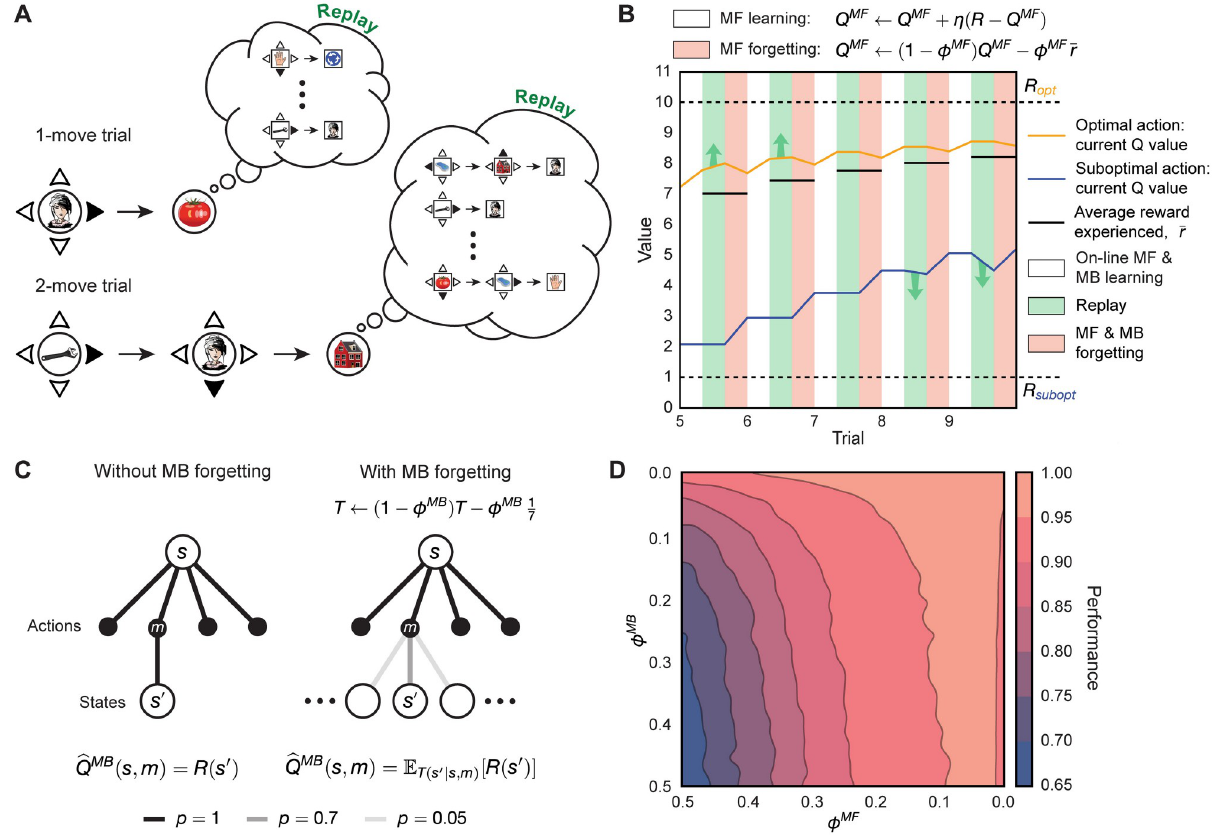
Fig 2. Algorithm description and the effects of replay and forgetting on model performance. (A) Schematic illustration of the algorithm in the behavioural task. Upon completing each trial, the algorithm uses its knowledge of the transition structure of the environment to replay the possible outcomes. Note that in 1-move trials the algorithm replays only single moves, while in 2-move trials it considers both single and coupled moves (thus optimizing this choice). (B) Effect of MF forgetting and replay on MF Q -values. After acting and learning on-line towards true reward R (white blocks; controlled by learning rate, η ), the algorithm learns off-line by means of replay (green blocks). Immediately after each replay bout, the algorithm forgets its MF Q -values towards the average reward experienced from the beginning of the task (red blocks; controlled by MF forgetting rate, ϕ MF ). Note that after trials 5 and 6, the agent chooses to replay the objectively optimal action, whereas after trials 8 and 9 it replays the objectively sub-optimal action. (C) Left: without MB forgetting, the algorithm’s estimate of reward obtained for a given move corresponds to the true reward function. Right: with MB forgetting (controlled by MB forgetting rate, ϕ MB ), the algorithm’s estimate of reward becomes an expectation of the reward function under its state- transition model. The state-transition model’s probabilities for the transitions are shown as translucent lines. (D) Steady-state performance (proportion of available reward obtained) of the algorithm in the behavioural task as a function of MF forgetting, ϕ MF , and MB forgetting, ϕ MB . Note how the agent still achieves high performance with substantial MF forgetting (high ϕ MF ) when its state-transition model accurately represents the transition probabilities (low ϕ MB